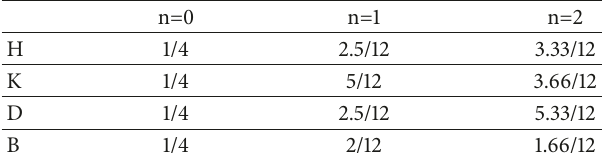
Table 1: An example of two-cycle transition of Markov matrix using the basic PageRank algorithm associated with Figure 2. Table 1 is reproduced from Payandeh, 2018 [11] (under the Creative Commons Attribution License/public